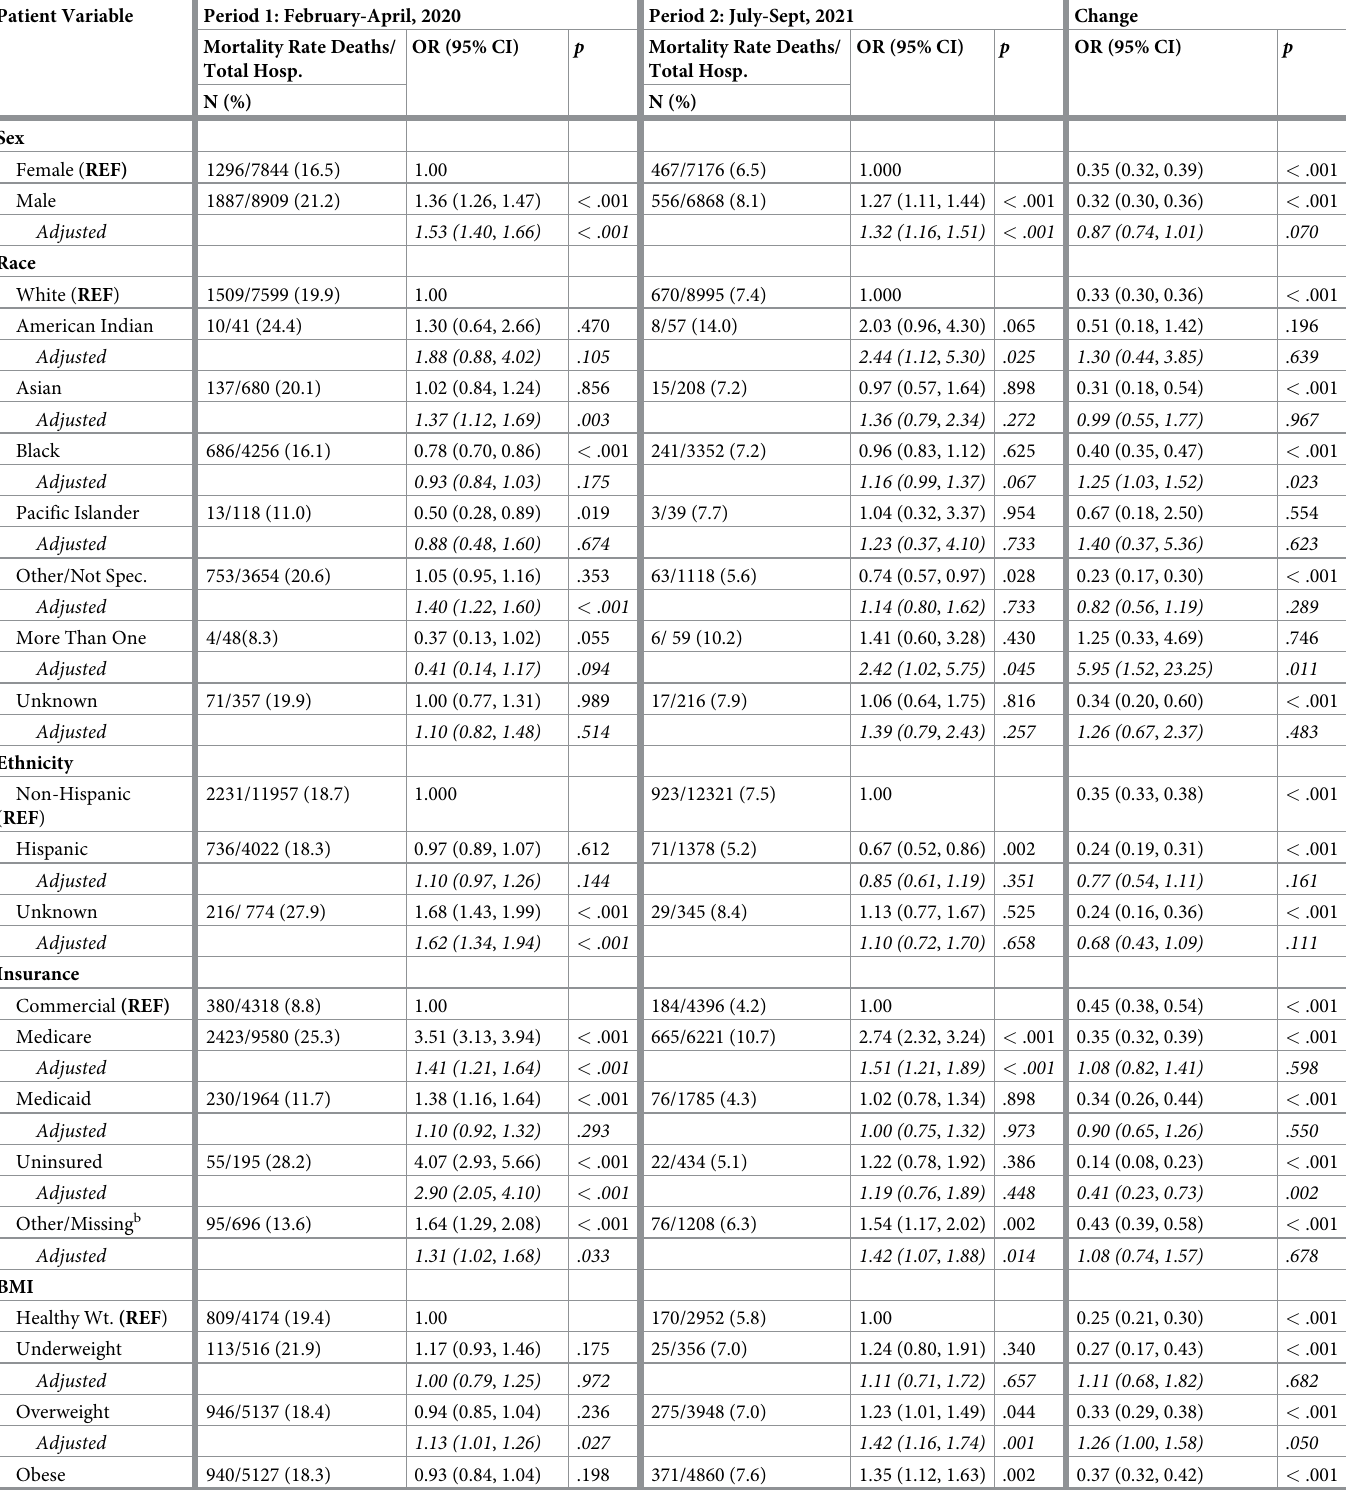
Table 2. Mortality rates for hospitalized COVID–19 patients during the first three and final three months of data collection. Patient